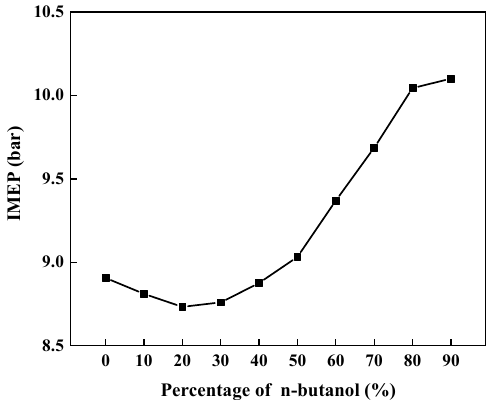
Figure 12. IMEP with different n-butanol percentages.